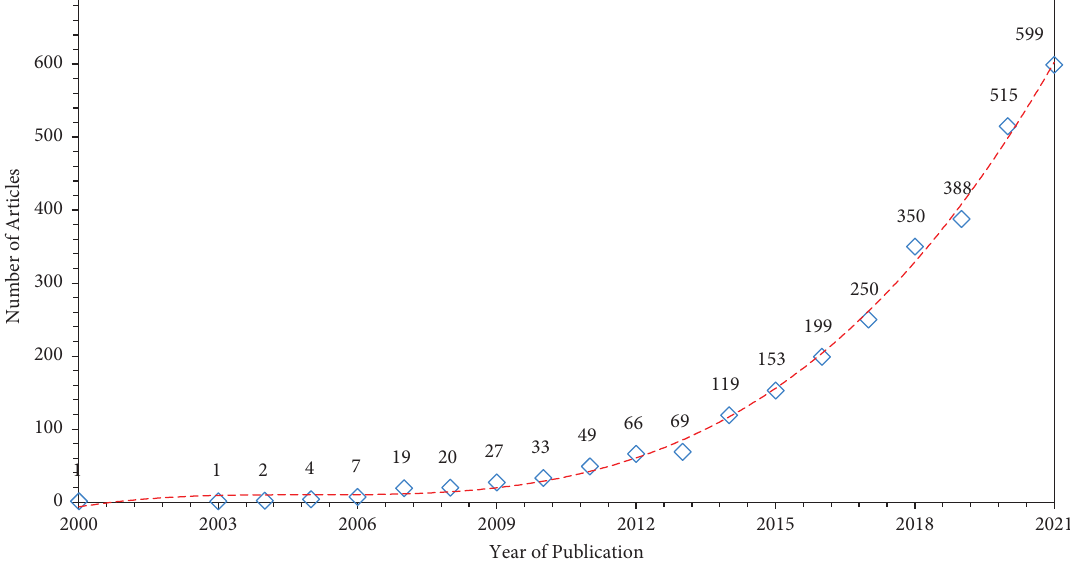
Figure 3: Number of publications per year from Scopus